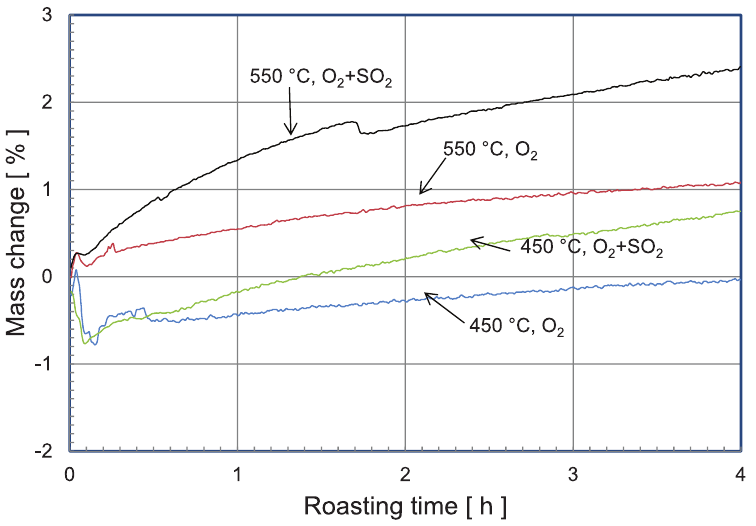
Fig. 1: Roasting kinetics of synthetic, dense Cu 2 Se in dry oxygen and oxygen – 20% SO 2 mixtures at 450–550 °C; note the slow but continuous rate of oxidation at all temperatures and atmospheres.